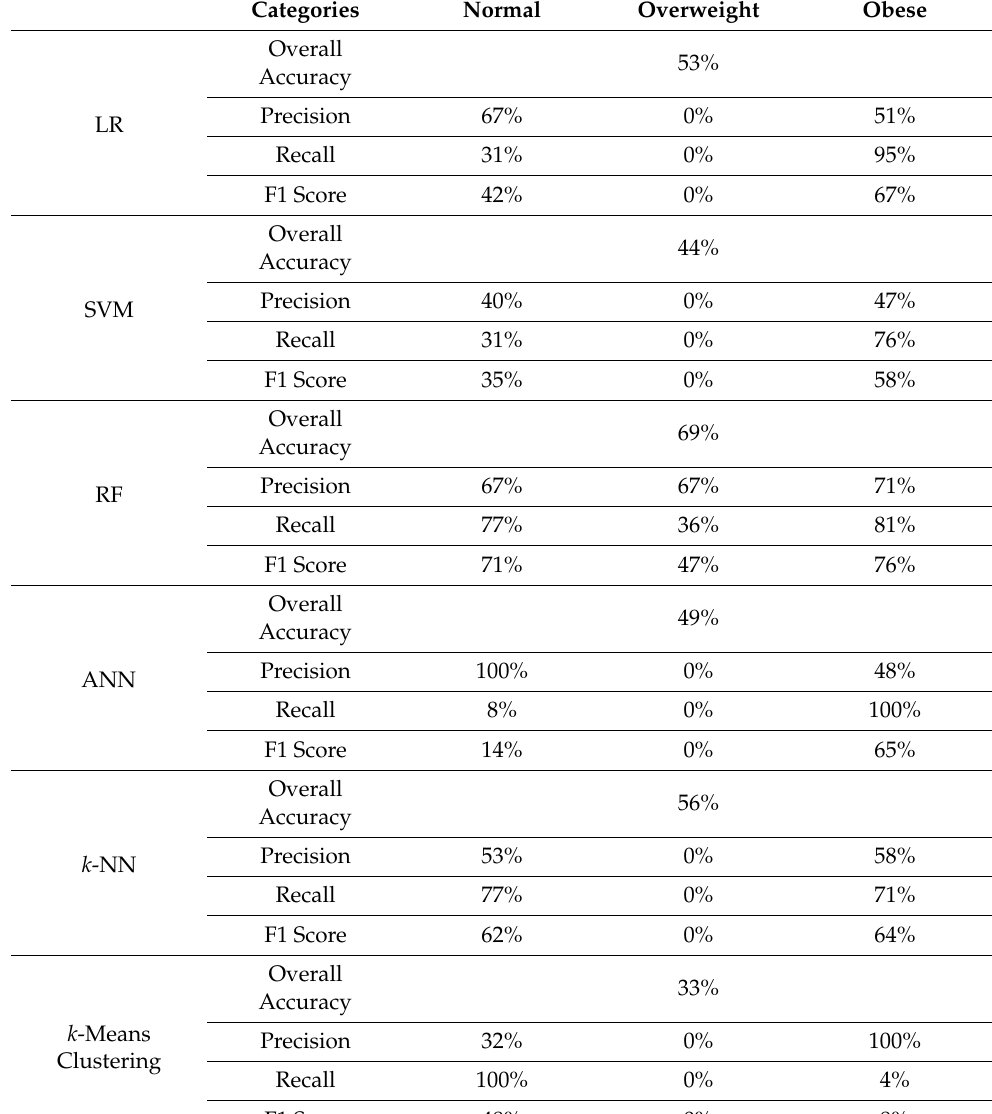
Table 6. Performance evaluations of ML techniques for determining obesity category based on early visits on an unbalanced dataset.